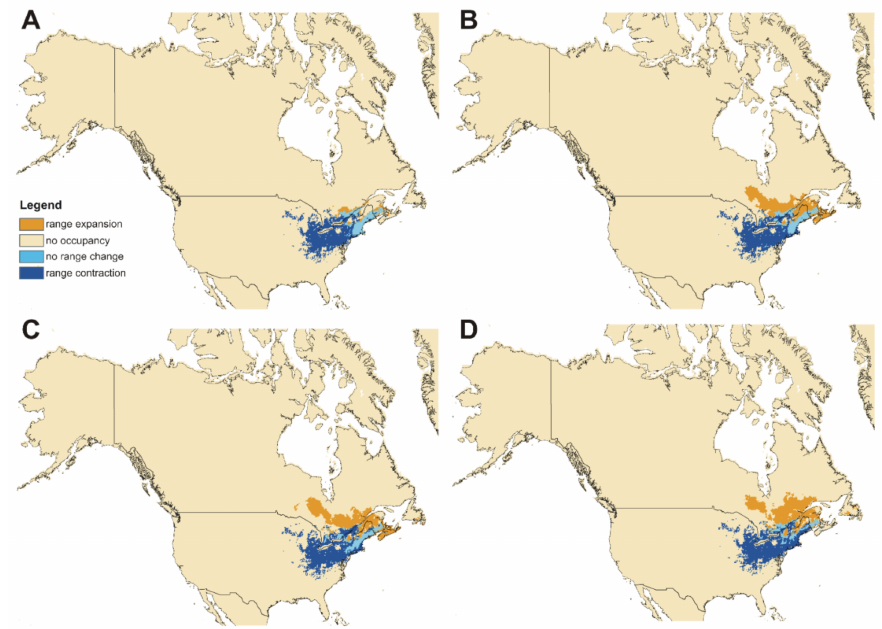
Figure 8. Future changes in the distribution of suitable niches of Cucujus clavipes clavipes according